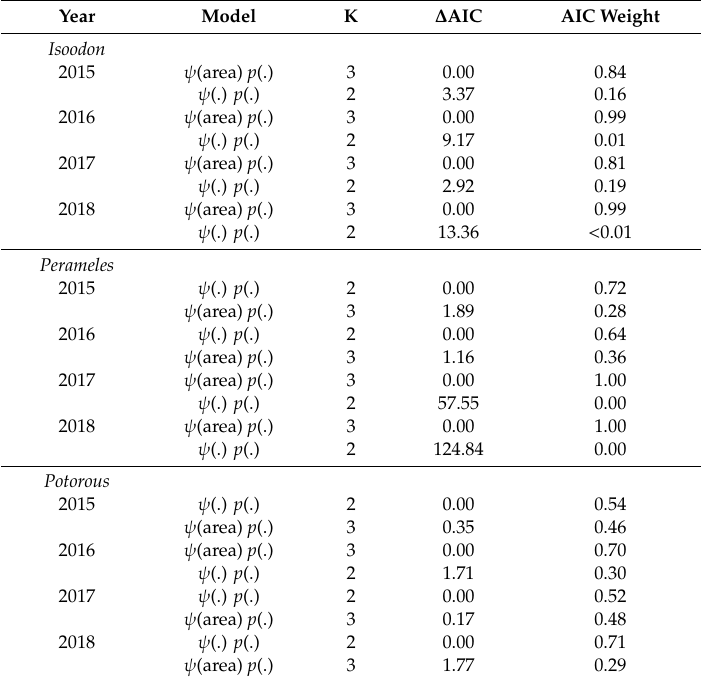
Table 5. Single-season occupancy model selection results for Isoodon , Perameles and Potorous between 2015–2018, based on a 40-day survey